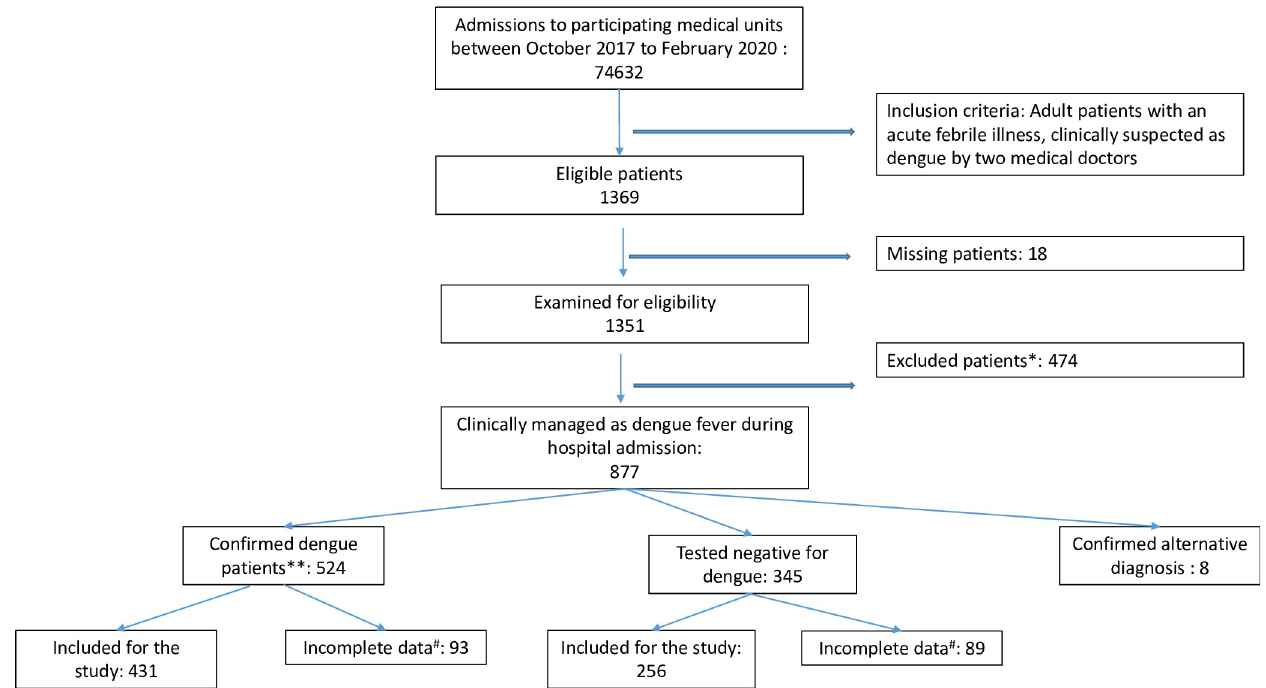
Fig 1. Flowchart showing patient recruitment to Colombo Dengue